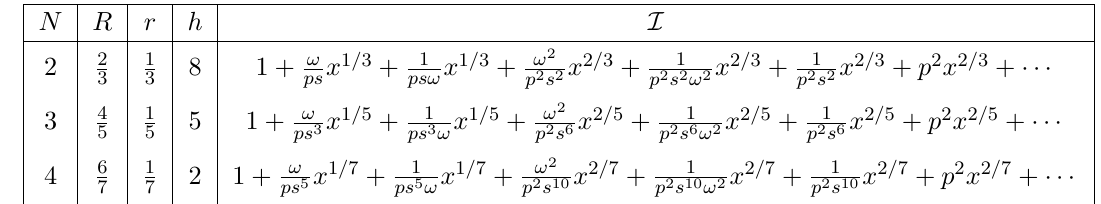
Table 6 . Computation of the superconformal index for di(cid:11)erent values of N up to order O In the last column we report the (cid:12)rst terms of the